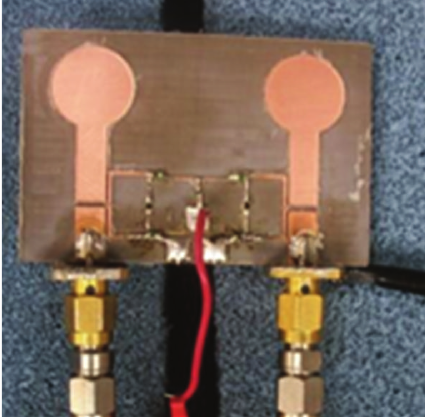
Figure 17: Normalized radiation pattern of the proposed pat- tern diversity tunable filter-antenna at 3.72 GHz (X-Z/Y-Z plane: solid/dotted